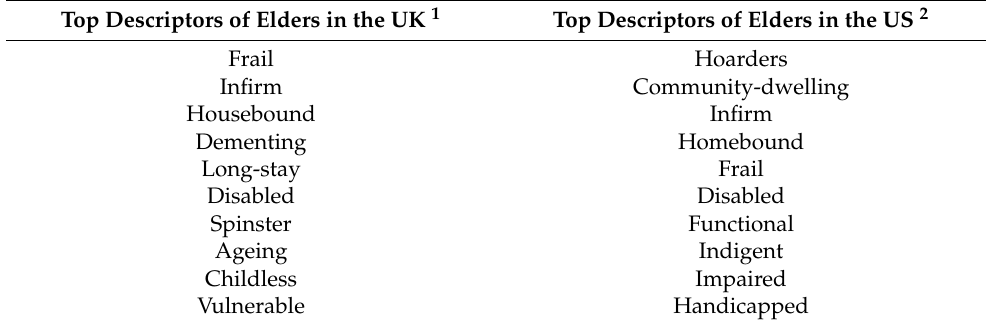
Table 2. Top 10 Descriptors of Elders in the UK and US in a 1.1-billion-word corpus of popular media. Top Descriptors of Elders in the UK 1 Top Descriptors of Elders in the US 2 Frail Hoarders Infirm Community-dwelling Housebound Infirm Dementing Homebound Long-stay Frail Disabled Disabled Spinster Functional Ageing Indigent Childless Impaired Vulnerable